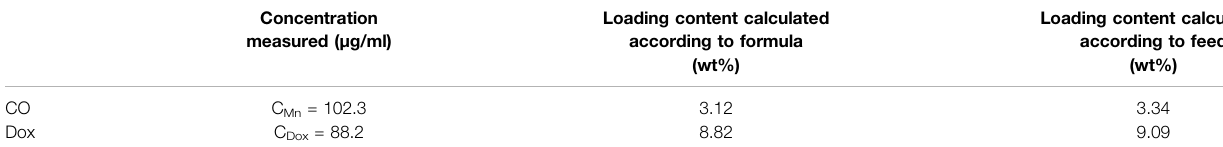
Concentration measured ( μ g/ml)